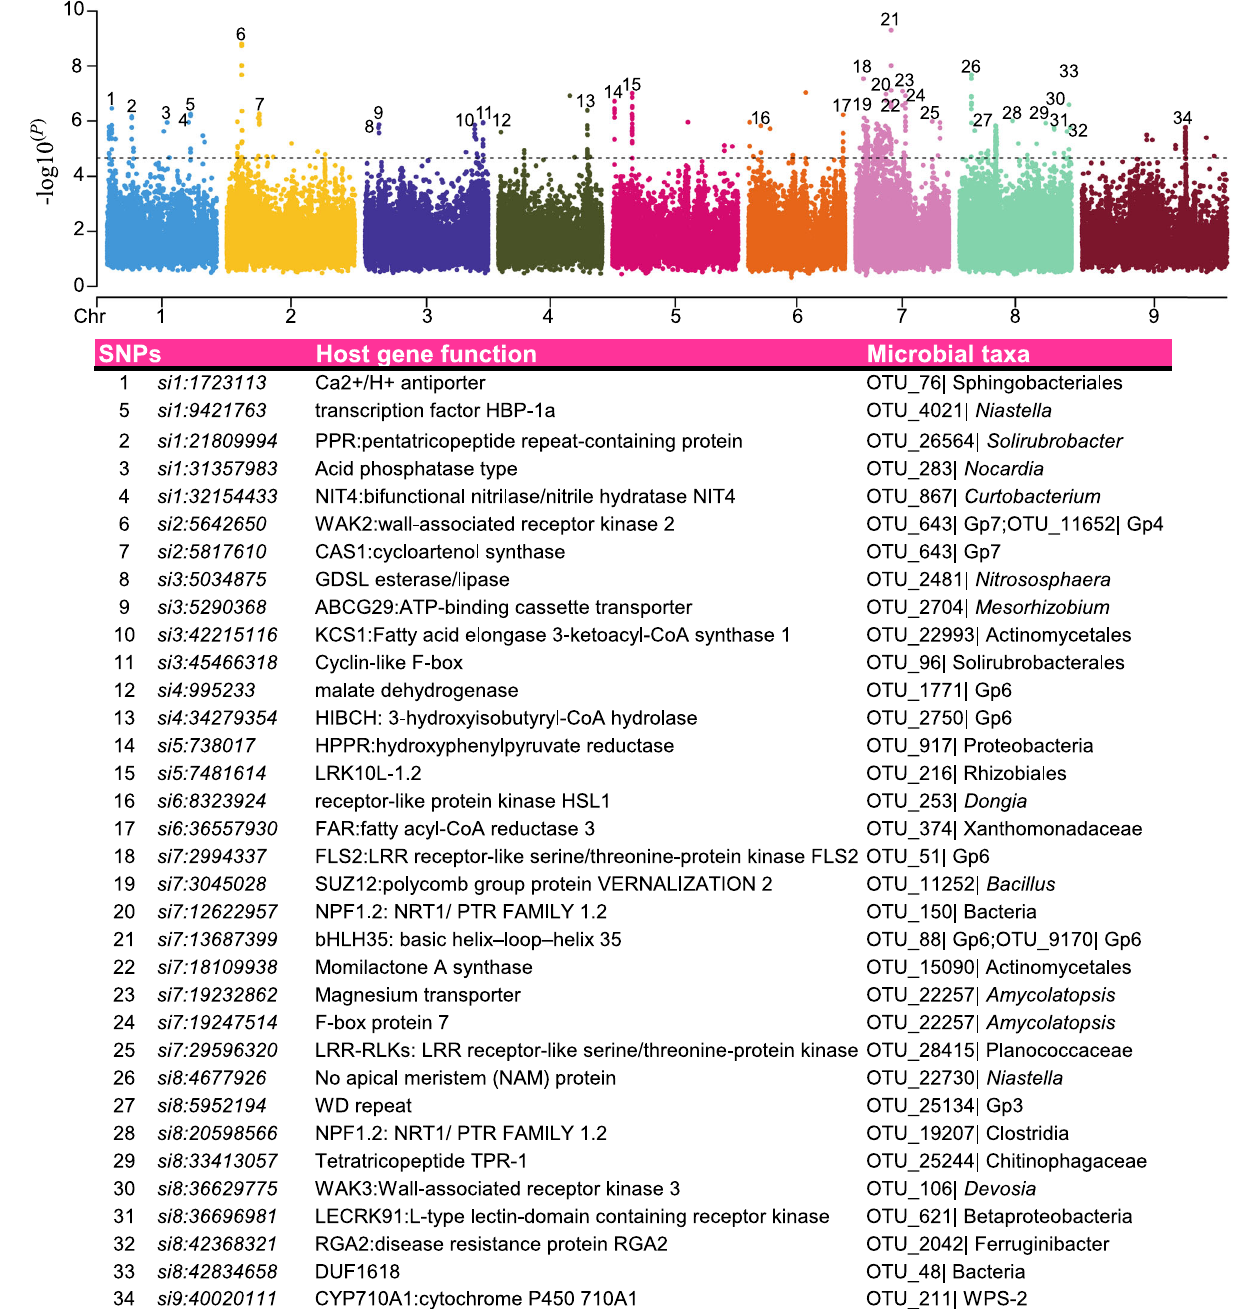
Fig. 5 | Host genetic variation correlated with common bacterial taxa. Man- hattan plots show the signi fi cant SNPs for microbial abundance. SNPs located in gene coding regions are labeled with numbers. Details of the associations